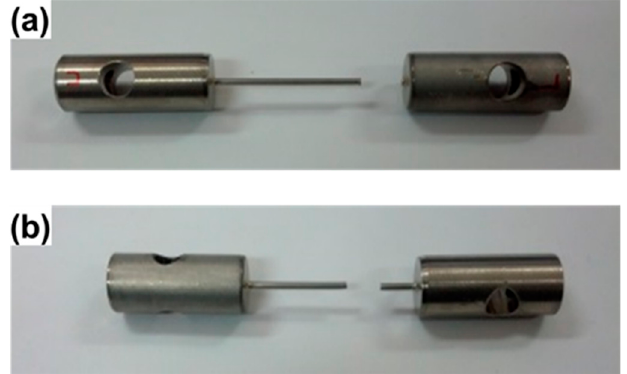
Figure 8. ( a ) Short-life (444,361 cycles) and ( b ) long-life (2,891,024 cycles) tube specimens at RT and σ max = 495 MPa.